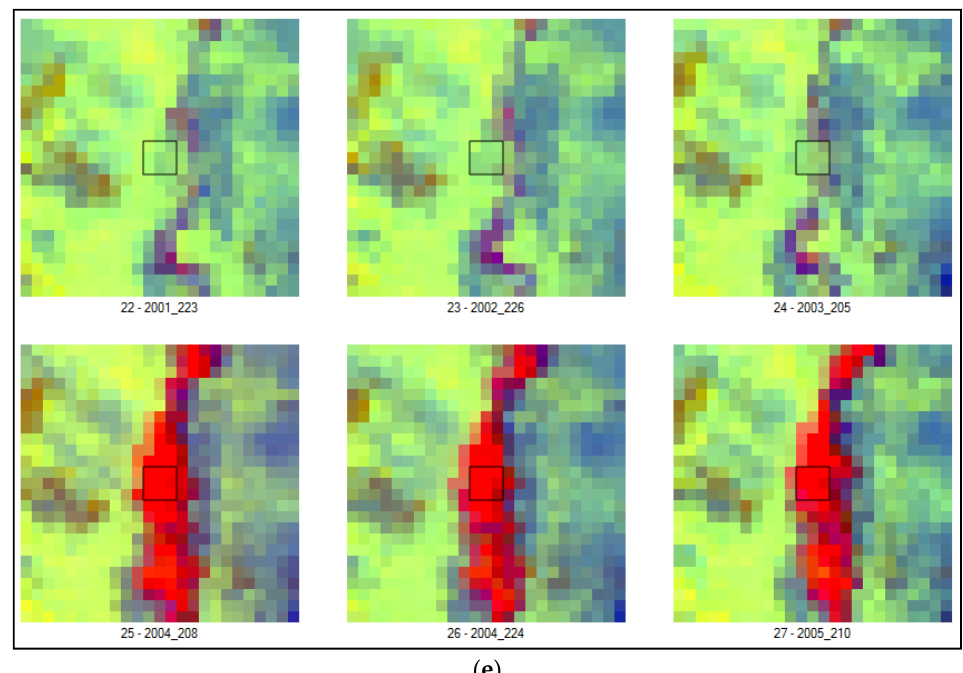
Figure A4. A 2004 Mass Movement patch generated by LandTrendr at North Cascades National Park. ( a ) Photo collected during field validation. Photo credit: NPS/ Jon Riedel (2004). ( b ) Pre-disturbance 1998 aerial photo as viewed in Google Earth™. ( c ) Post-disturbance 2006 aerial photo as viewed in Google Earth™. ( d ) TimeSync spectral trajectory of nine pixels around patch centroid. ( e ) Part of the series of tasseled-cap image chips covering pre- and post-disturbance years as viewed in TimeSync.